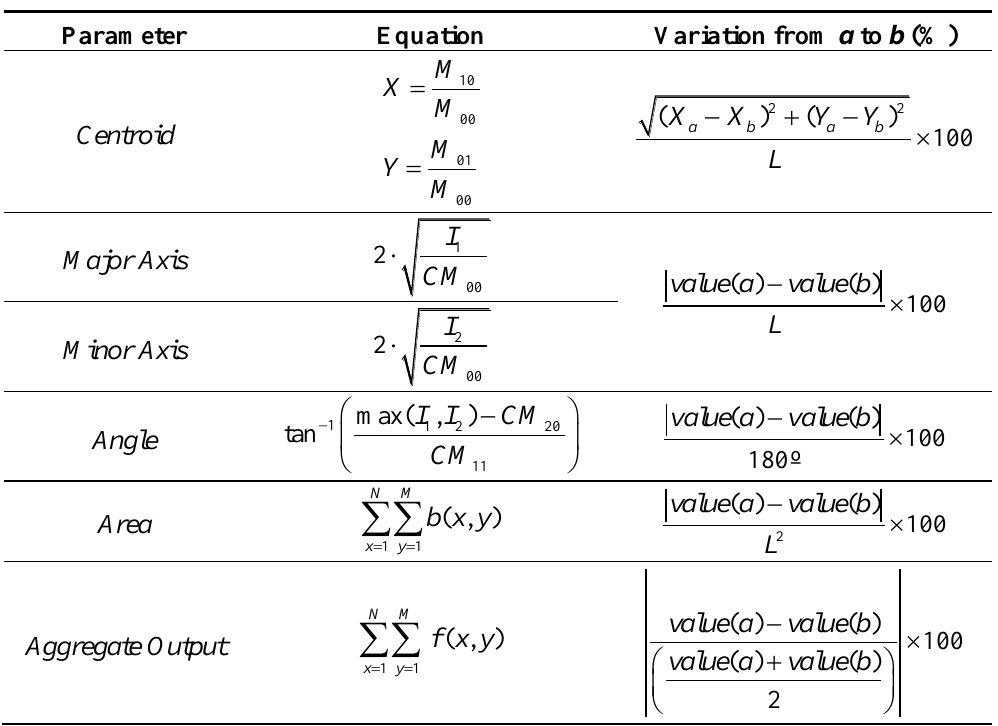
Table 4. Parameters obtained from the processing of the tactile image and used commonly in control